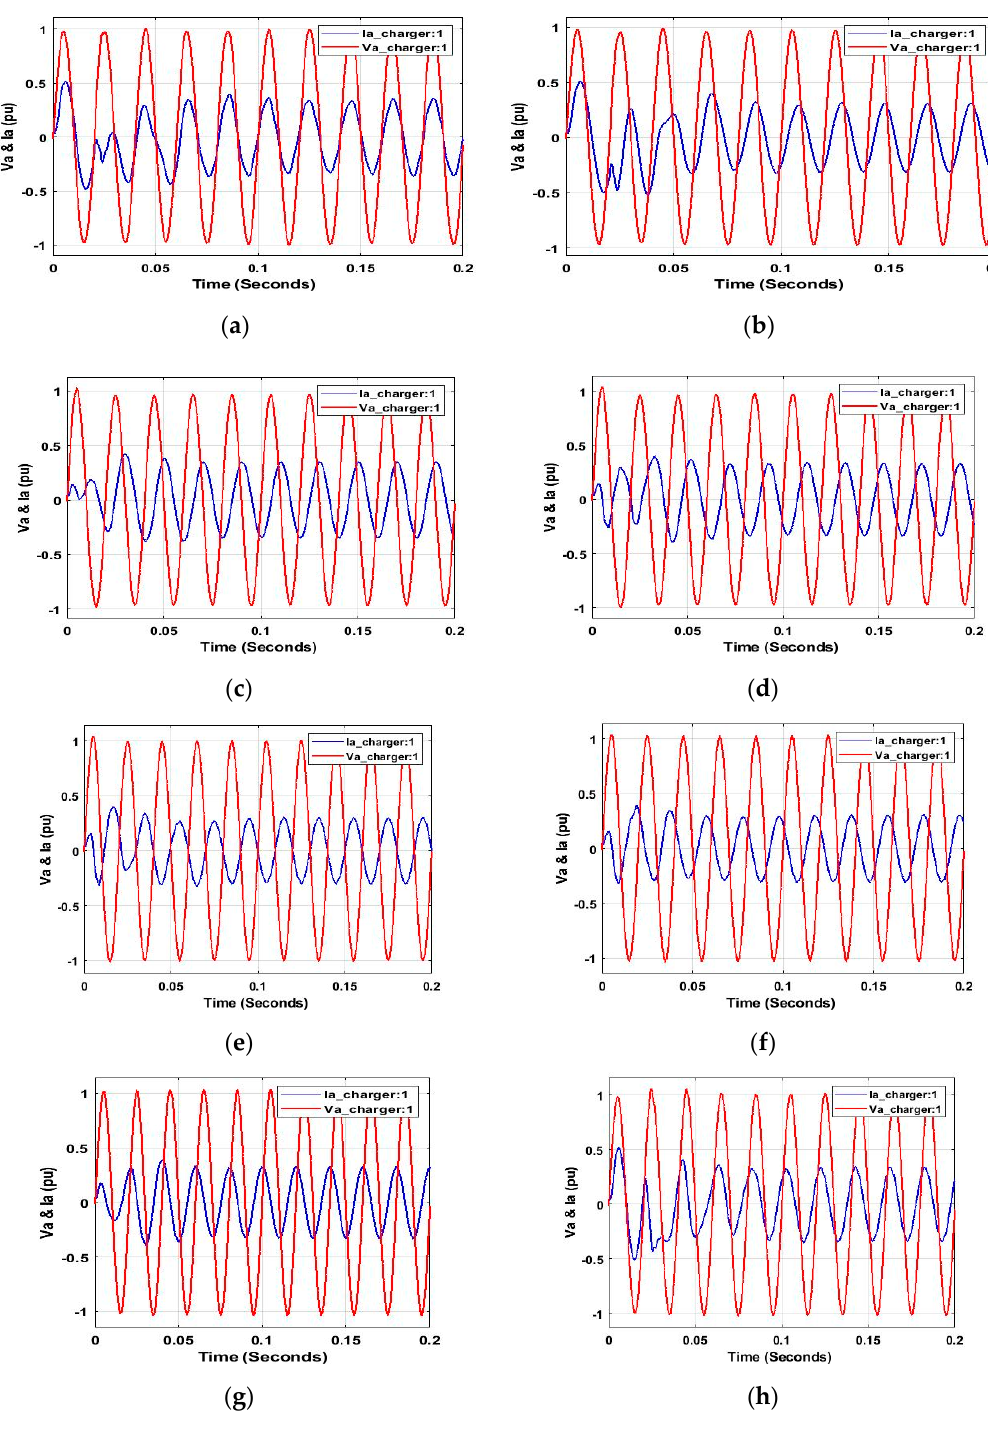
Figure 10. Per unit charger voltage (blue) and charger current (red) simulation results for: ( a ) P = 53